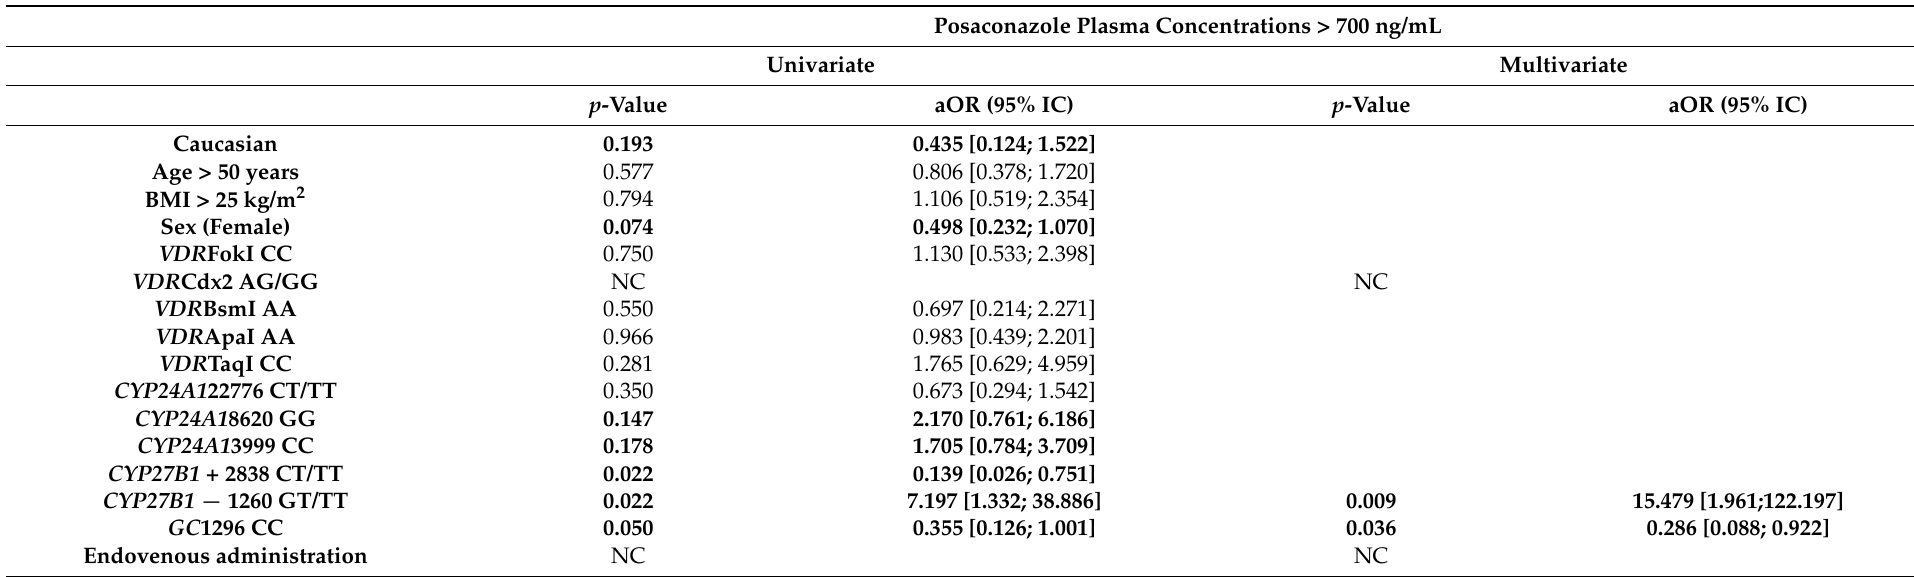
Table 3. Logistic regression analysis with predictors of posaconazole plasma concentrations over the efficacy cut-off limits (>700 ng/mL). Bold characters represent statistically significant values. Bold characters represent statistically significant values. NC: not statistically comparable since one group is